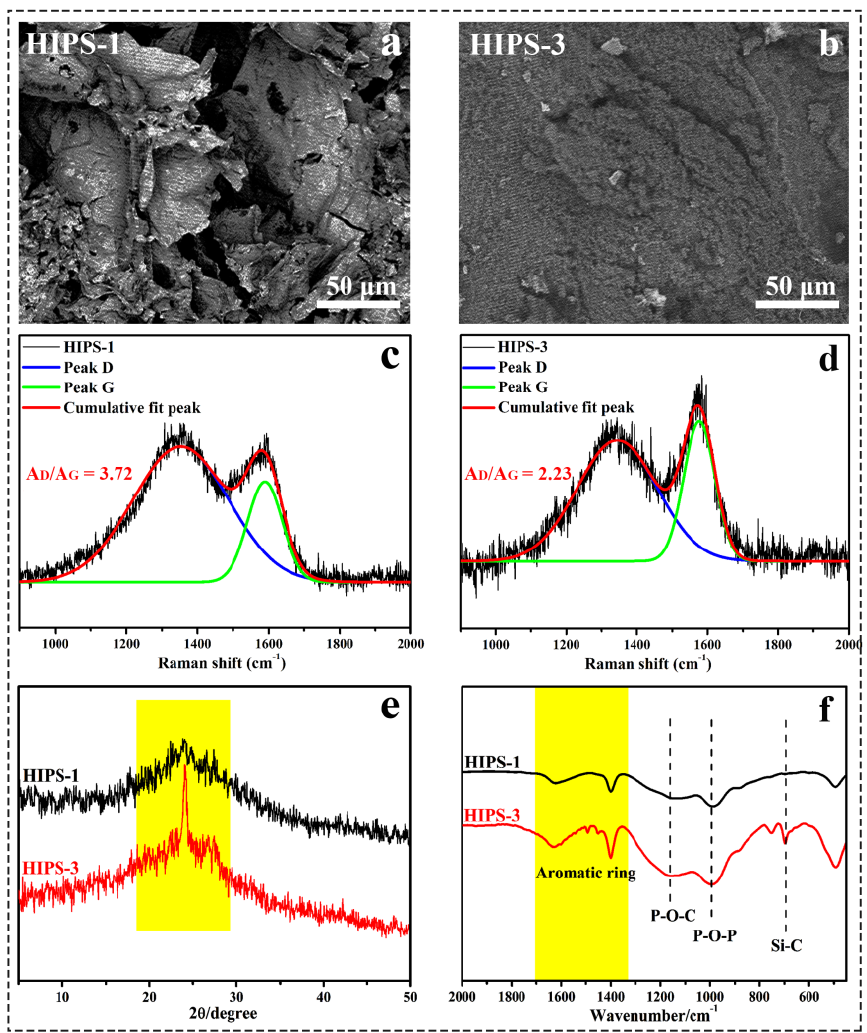
Figure 10. The SEM images ( a , b ), Raman curves ( c , d ), XRD ( e ) and FTIR ( f ) curves of carbonaceous char for the HIPS-1 and HIPS-3 compounds.